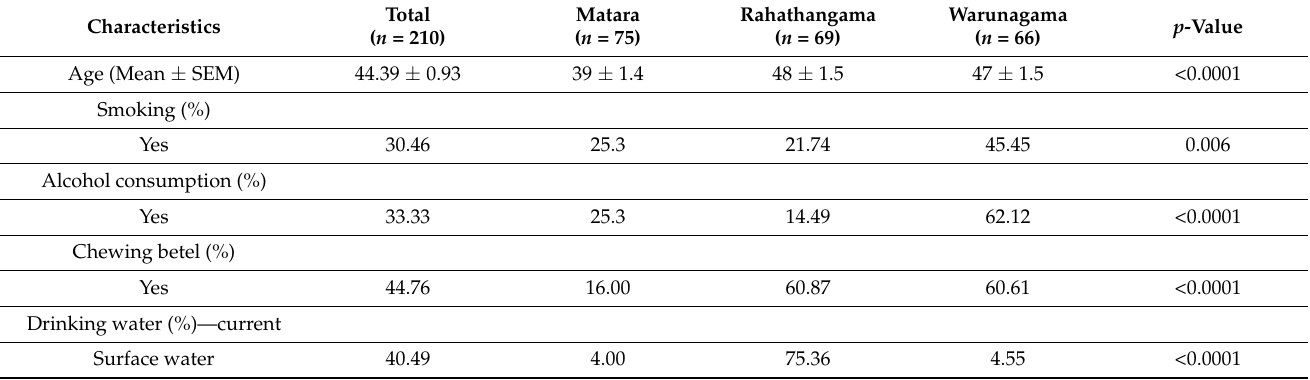
Table 1. Baseline characteristics of the male and female farmers in the